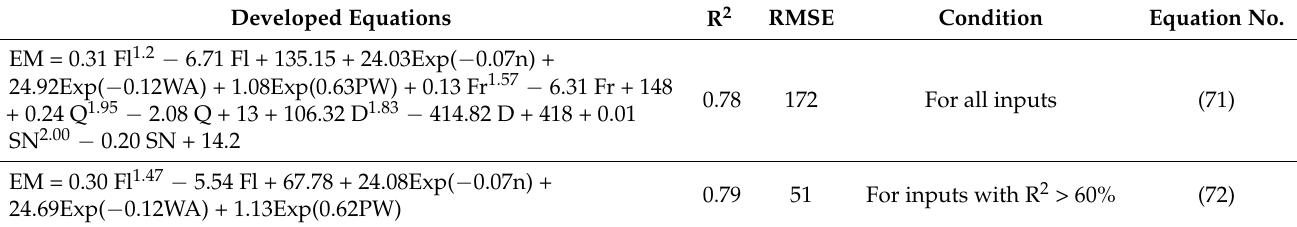
Table 9. Developed equations using the NLMVR